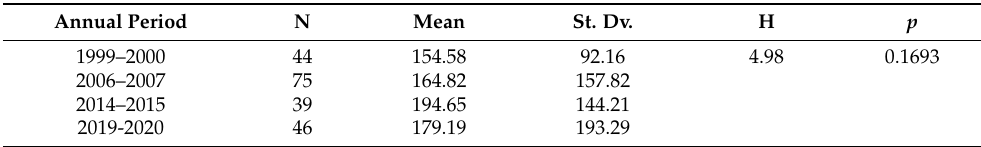
Table A13. Euclidean Distance’s Kruskal Wallis tests between time periods for the Santo Tom é district.